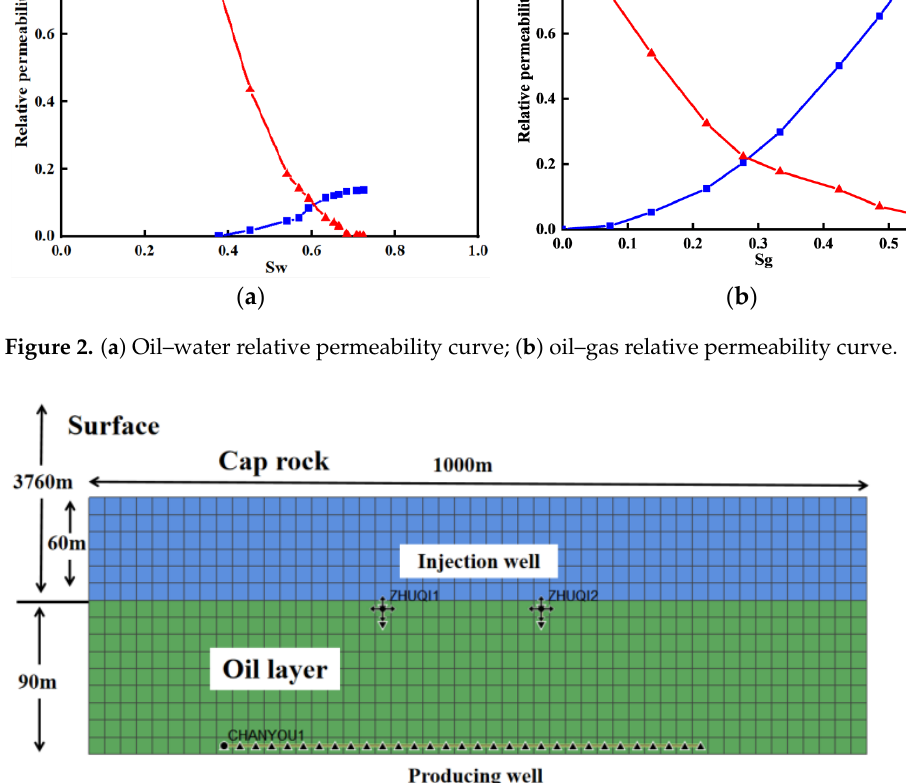
Figure 3. Schematic view of the model geometry used in the study.